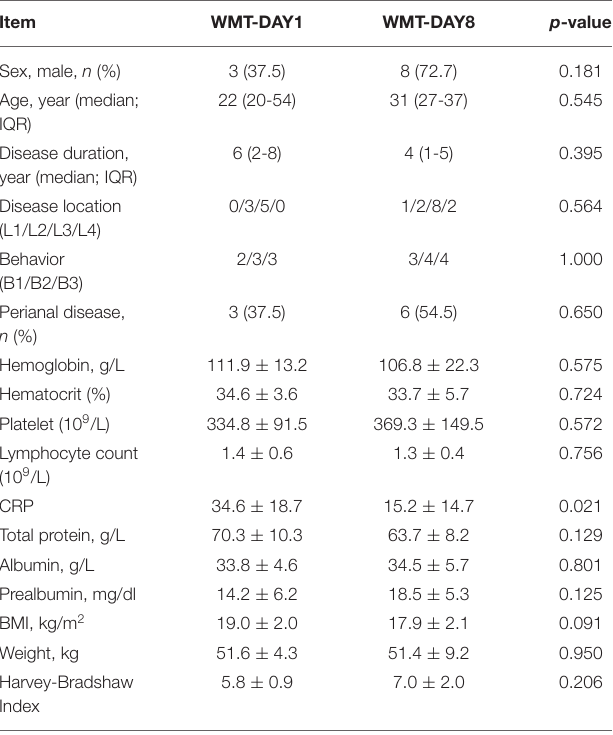
TABLE 1 | Baseline demographic and clinical characteristics of the patients.